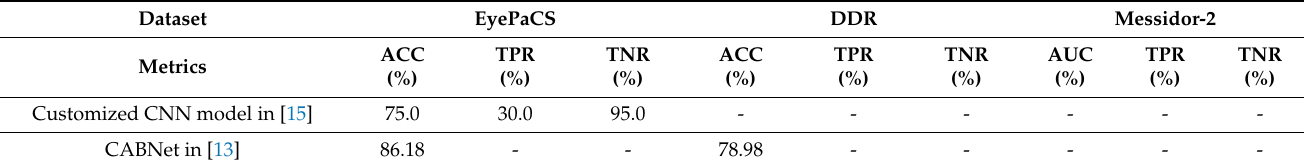
Table 7. Comparison of the proposed method with other previous methods: ‘-‘ indicates that no value was provided for the